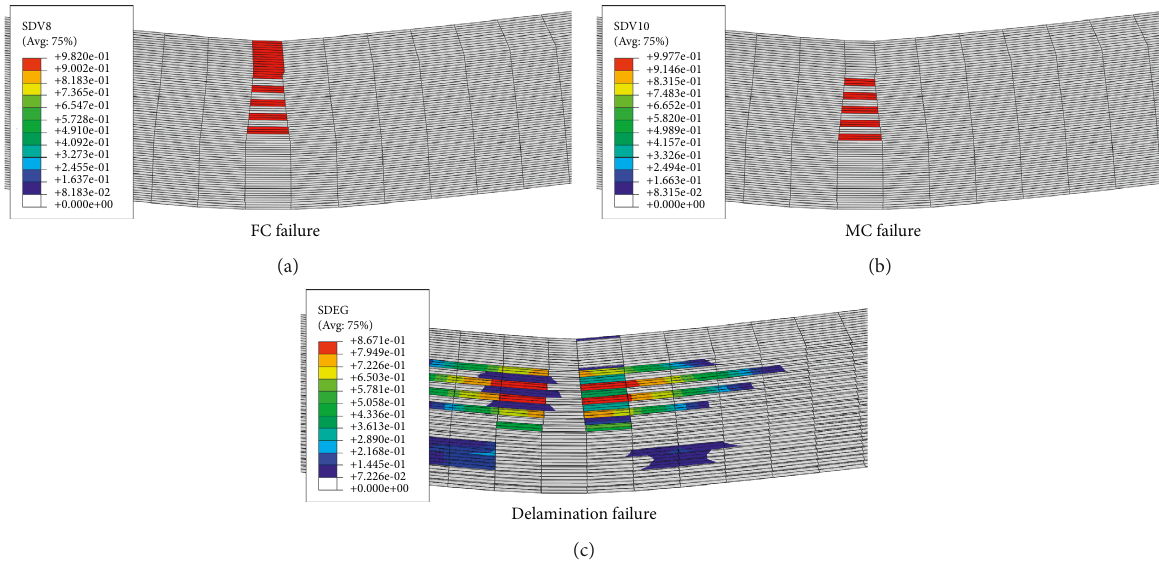
Figure 6: Failure modes at characteristic point B. (a) FC failure, (b) MC failure, and (c) delamination